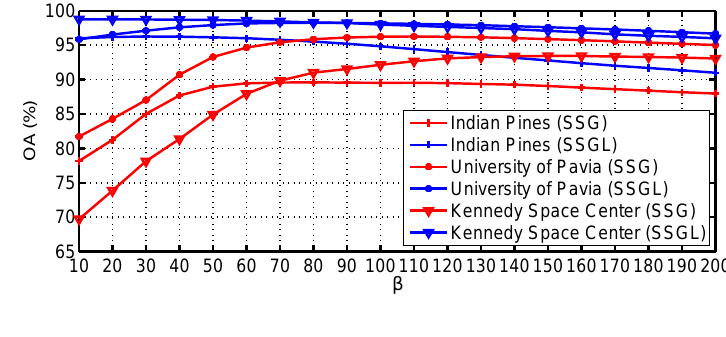
Figure 8. OA as a function of β